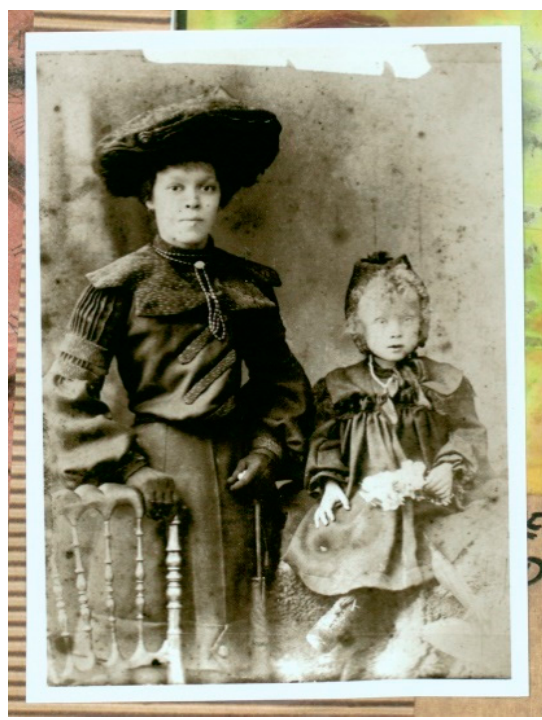
Figure 9. Eliza Head and her sister, Mabel Head, c. 1900. The pair were the granddaughters of a former black American slave who had escaped a Florida plantation and settled in Bristol in the 1850s where he worked as a stonemason and met his white wife, Louisa. Image courtesy of Bristol Archives, 43650 7–21.